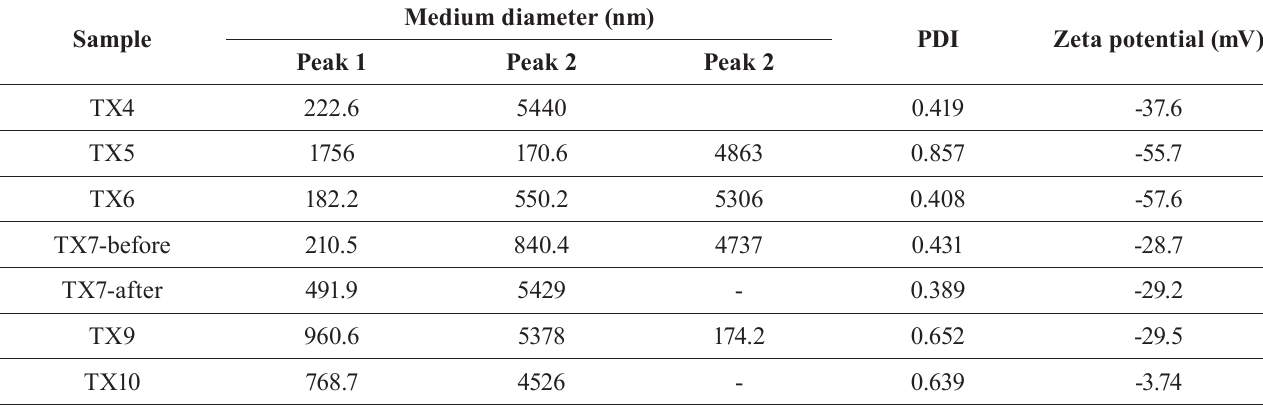
TABLE II - Relation of particle size and zeta potential